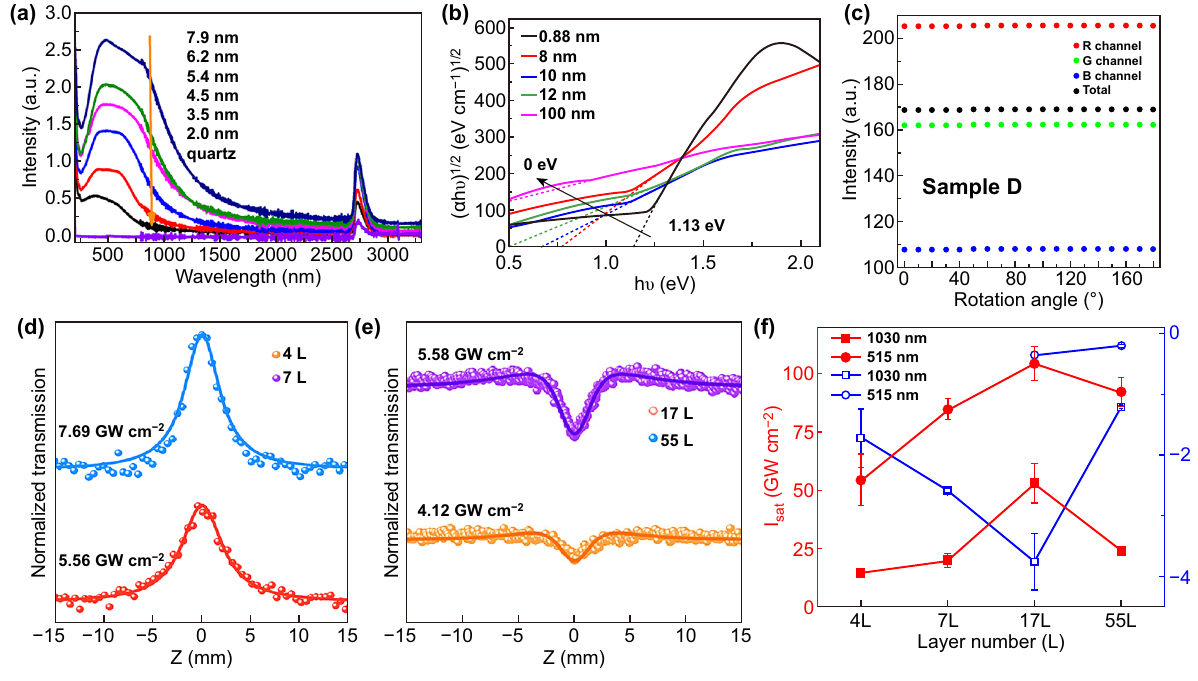
Fig. 6 Optical properties of PtSe 2 . a Thickness‑dependent UV–Vis–IR absorption spectra of PtSe 2 film on sapphire substrate. Reproduced with permission [82]. Copyright 2019, AIP Publishing. b Thickness‑dependent Tauc plots of PtSe 2 film. Reproduced with permission [28]. Copyright 2018, John Wiley and Sons. c Intensity of red channel, green channel, blue channel, and the total intensity at different rotation angle. Repro‑ duced with permission [81]. Copyright 2019, IOP Publishing. d , e Open aperture Z‑scan results of 4L, 7L, 17L, and 55L PtSe 2 films at 1030 femtosecond pulse excitation. f Saturation irradiance ( IS at ) and g nonlinear refractive index ( n 2 ) of 4L, 7L, 17L, and 55 L PtSe 2 films at 1030 nm and 515 nm. Reproduced with permission [84]. Copyright 2019, John Wiley and